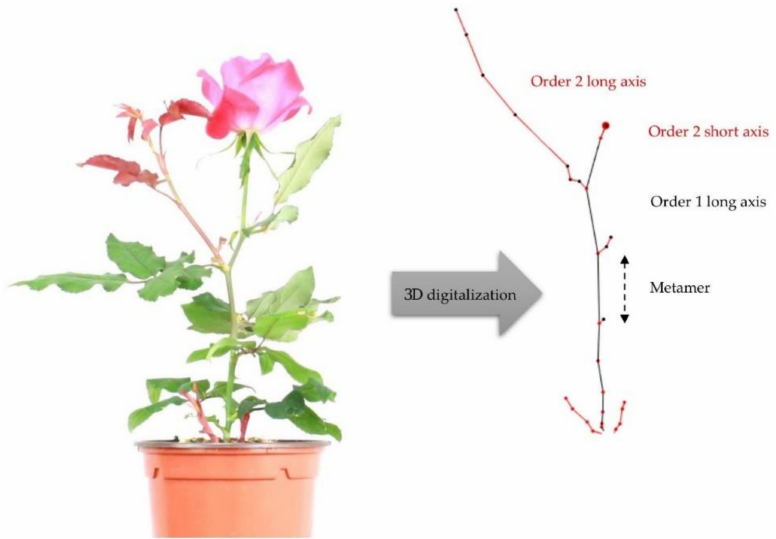
Figure 2. Representation of the plant architecture obtained by 3D digitalization with two types of axes (short and long), one metamer, and two branching orders: order 1 and order